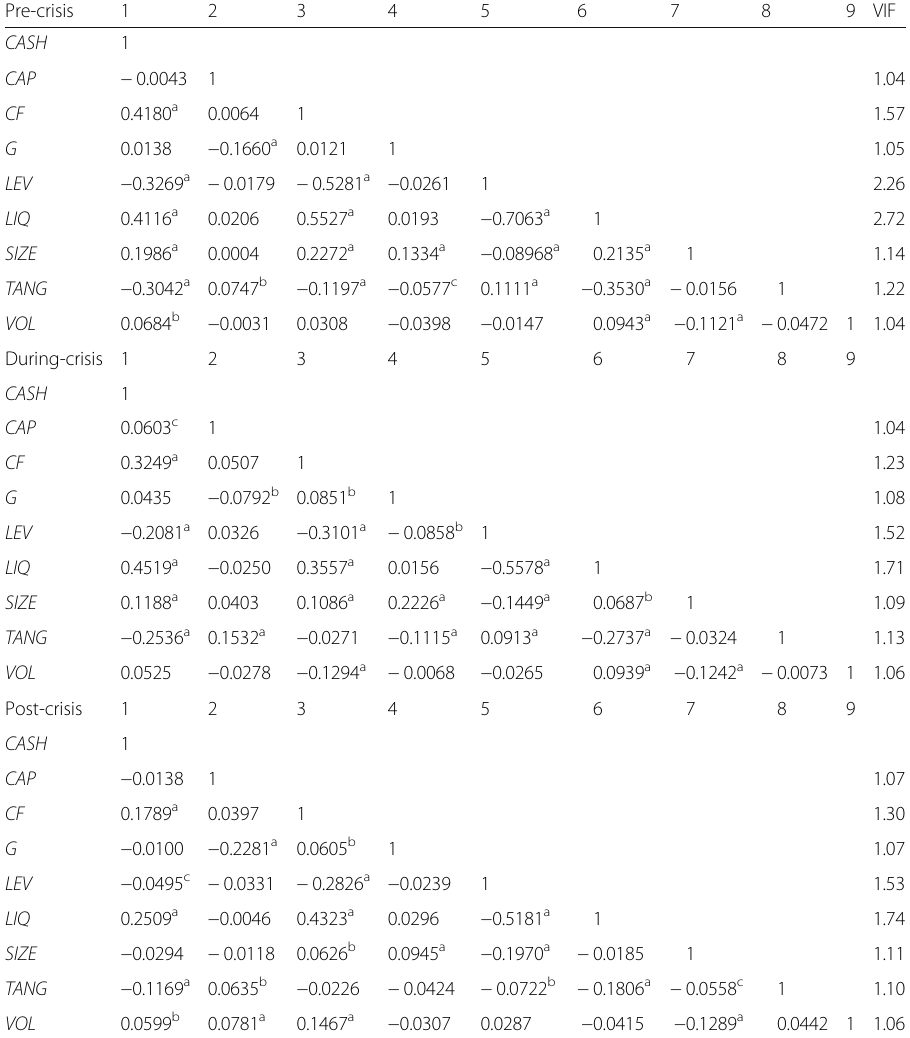
Table 3 Correlation matrix